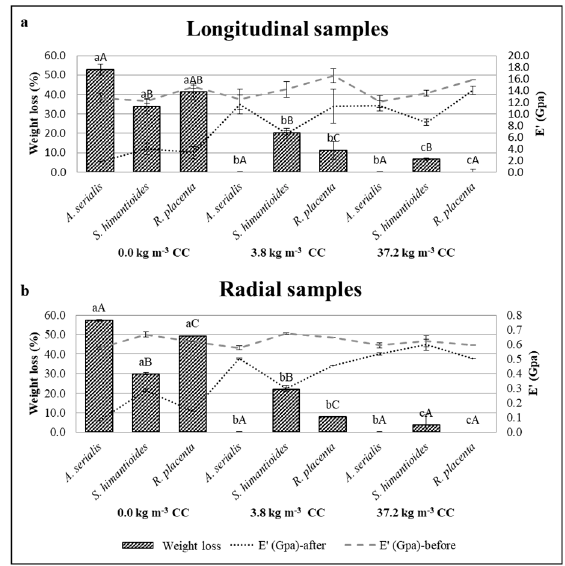
Figure 4. Effect of brown rot fungi on weight losses and stiffness of CC-treated wood after 12 weeks incubation. ( a ) Longitudinal samples. ( b ) Radial samples. Lowercase letters denote significant differences between the wood preservative concentrations for the same brown rot fungi. Uppercase letters denote significant di ff erences between brown rot fungi for the same wood preservative concentrations. Data represented as mean ± SD of three replicates ( p <